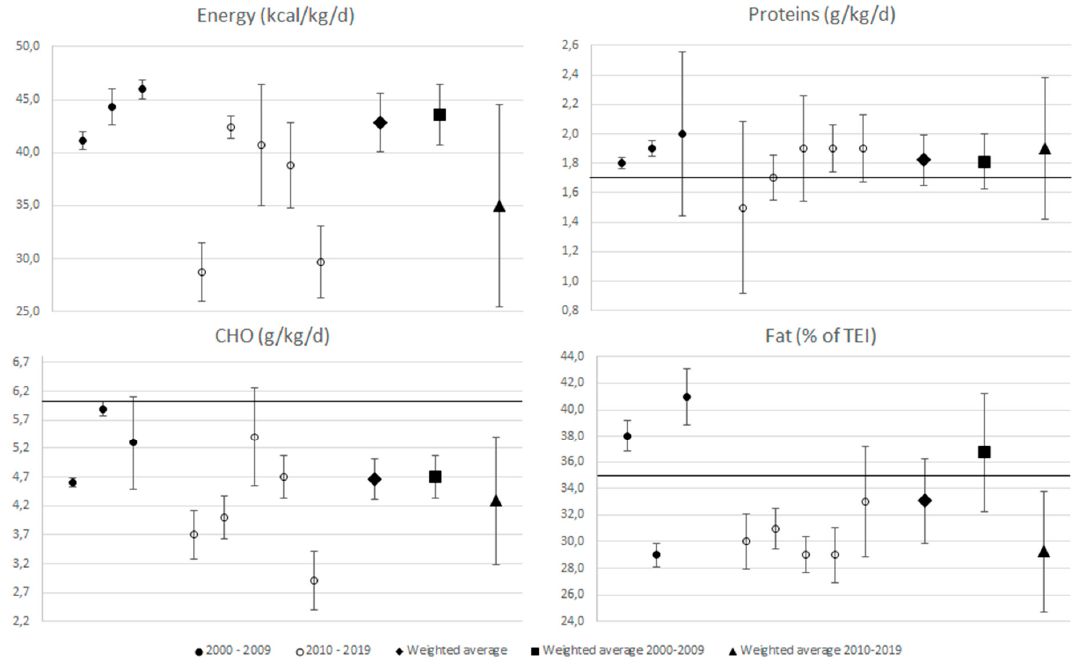
Figure 3. The forest plot for seniors. There are presented studies from 2000–2009 on the left side and from 2010–2019 on the middle and the weighted averages on the right side. Black line demonstrates higher level of recommended value in proteins and fat and lower level in CHO. If 95% CI does not cross the line, the result is statistically significant.